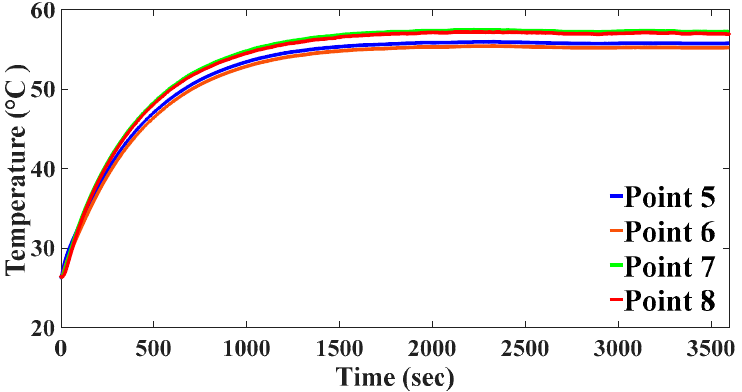
Figure 26. Type I heat-source temperature.